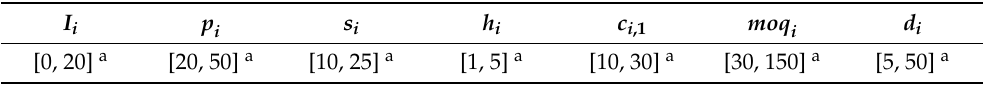
Table 6. Parameters setting of Experiment